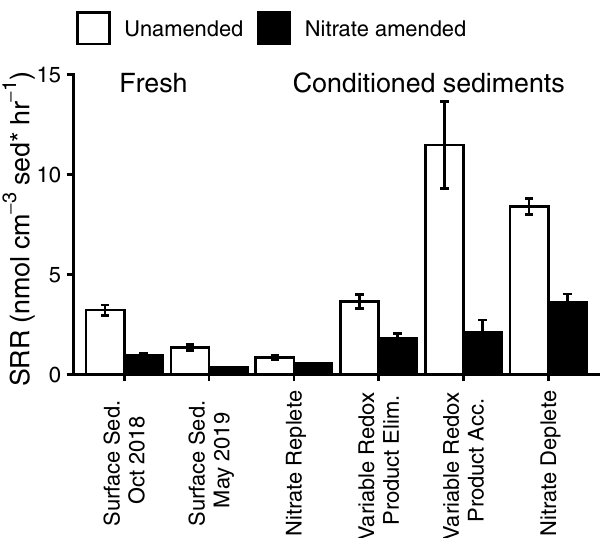
Fig. 2 Sulfate reduction rates: Sulfate reduction rates (SRR) from sediments amended with NO 3- (black bars) or without NO 3- (white bars) in nmol cm − 3 sed. hr − 1 . Sulfate reduction began immediately in all incubations, and rates are calculated from the period of time where rates were linear. See Supplementary Tables 1 + 2 for associated statistics. All rates had an adjusted R 2 of at least 0.85, except for the Variable Redox / Product Accumulation condition, which had an R 2 of 0.56 when amended with NO 3- , and 0.75 without NO 3- . All error bars represent standard error. The conditioned sediment incubations were carried out in October